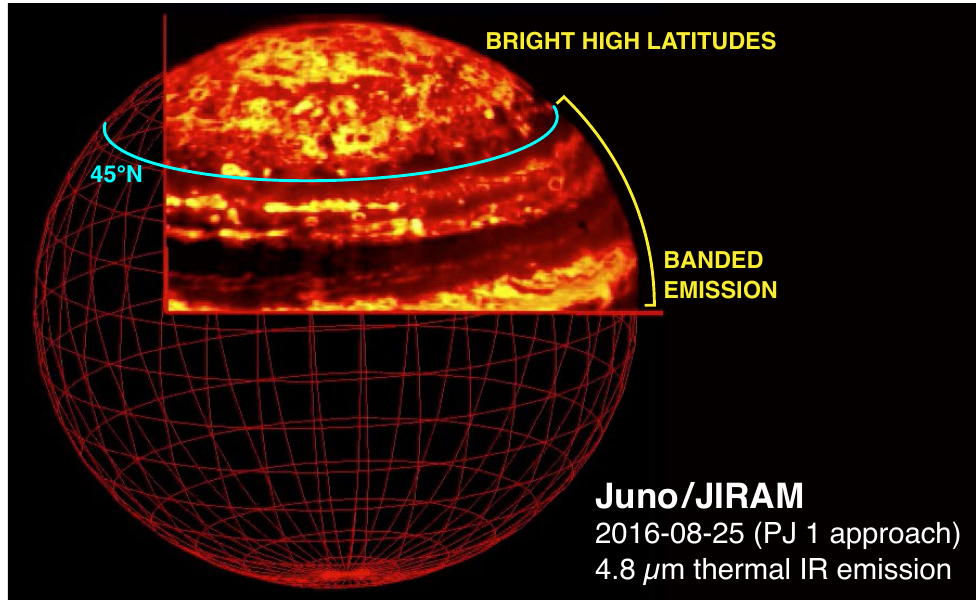
Figure 7. Infrared imaging from the JIRAM instrument [83] on Juno shows a transition from low- latitude banded emission to a high-latitude region with elevated emission overall. The image shows JIRAM data superposed on a wireframe planetocentric coordinate grid, with the planetographic latitude of 45 ◦ N marked in cyan. Figure adapted from an animation released on the official JPL-NASA YouTube channel at